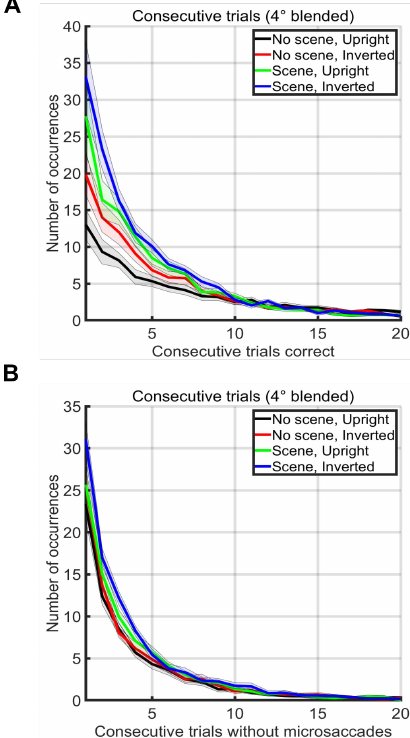
Figure 6. (A) Number of occurrences of consecutive sequences of correct trials without a mistake (x-axis) during two blocks of 500 trials in each condition (see legend). Note that sub-runs of consecutive trials were not counted (e.g. a run of 3 correct trials did not change the totals for runs of length 1 or 2) (B) Number of occurrences of consecutive sequences of trials without a microsaccade. Note that sub-runs of trials without microsac- cades were not counted (e.g. a run of 3 trials did not change the totals for runs of length 1 or